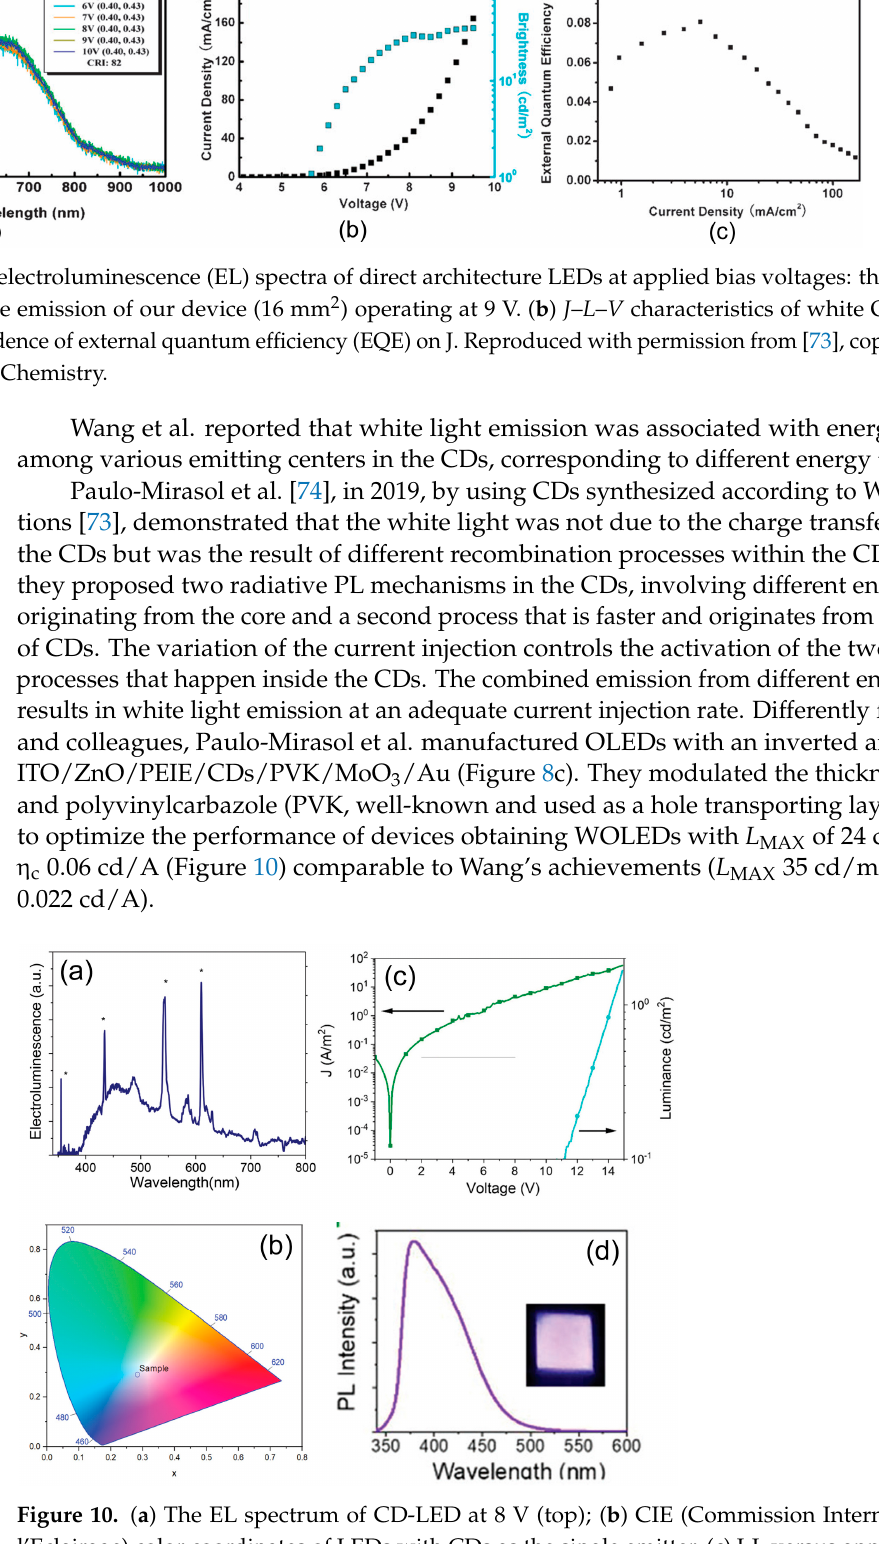
9 of 25 Figure 8. Schematic representation of ( a ) CD synthesis and typical devices architectures: ( b ) direct [74] and ( c ) inverted [73] in which CDs are incorporated as emitters. Electrically driven WOLED-featured electroluminescence (EL) peaked at 550 nm, with current density ( J ) of 160 mA/cm 2 , a maximum luminance ( L MAX ) output of 35 cd/m 2 (Figure 9a,b), and a current efficiency ( η